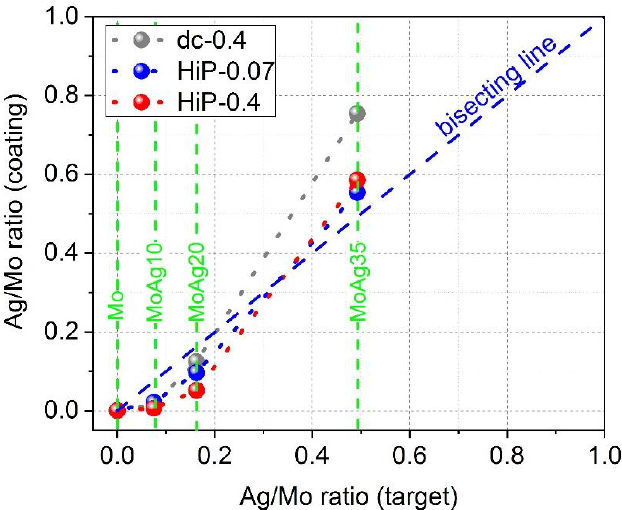
Figure 3. Ag/Mo ratio of coating vs. target. The dotted lines are a guide to the eye. A dashed bisecting line has been added. This dashed line represents the case when the Ag/Mo ratio in the coating resembles the one of the composite target. The green text and vertical dashed lines mark the corresponding target materials.